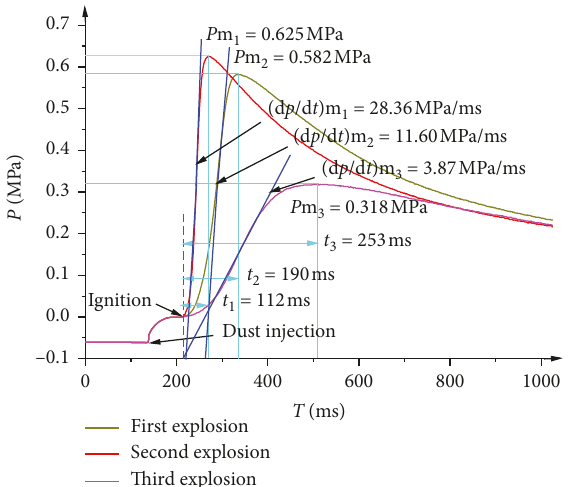
Figure 4: The evolutionary curves of the explosion overpressures in the first three